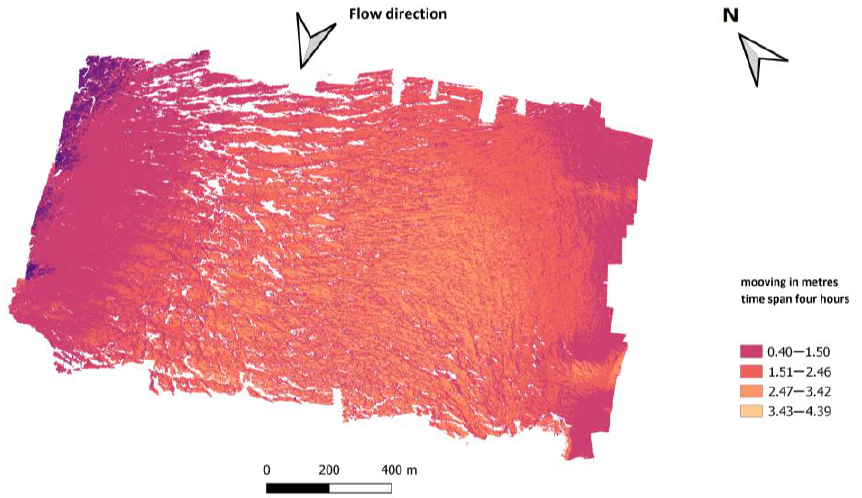
Figure 14. Areas of significant change on the Knud Rasmussen Glacier in the time span of four hours. The values: the flow speed; the purple colored parts on the left are caused by missing data from flight No.1.